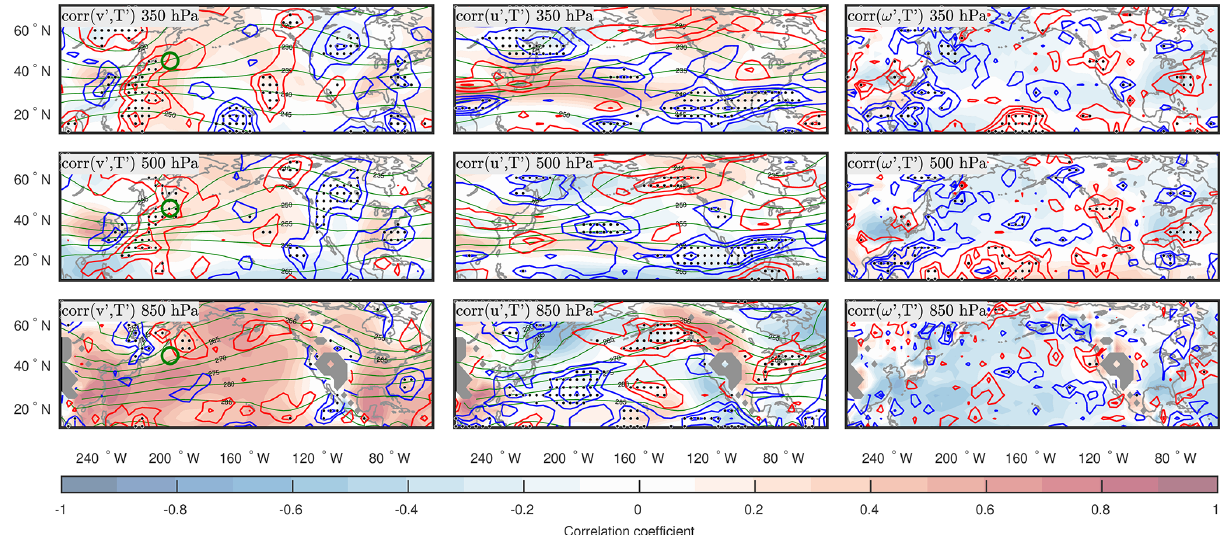
Figure 6. Maps of climatological correlation coefficients (color shading) between v (cid:48) and T (cid:48) (left), between u (cid:48) and T (cid:48) (center), and between ω (cid:48) and T (cid:48) (right). The respective composite differences between winters of SVD1 SST > 0 . 75 and SVD1 SST < − 0 . 75 are superimposed with blue and red contours with an interval of 0.1 for negative and positive differences, respectively. For reference, the temperature climatology is shown with green lines. Composite differences that are significant at the α FDR = 0 . 1 significance level are dotted. The green circle in the left panels indicates the reference location for Fig. 8.